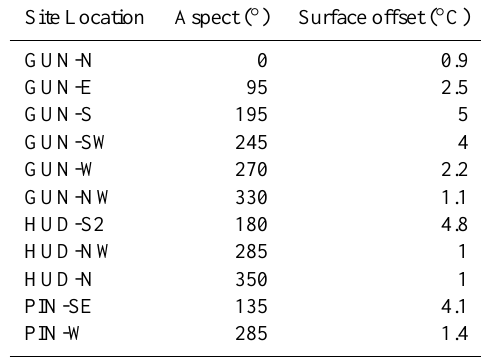
Table 2. Surface offsets for all monitored near-vertical